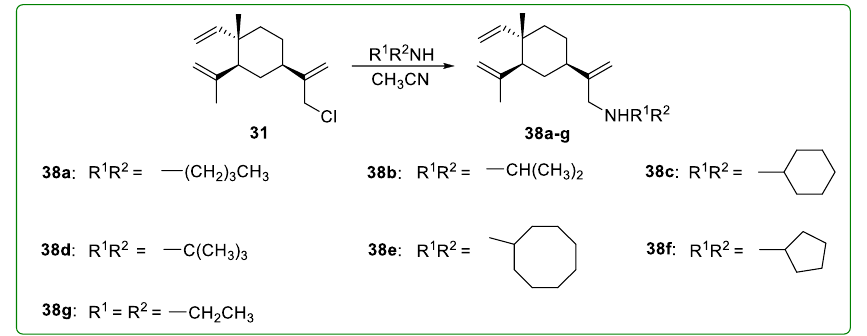
Figure 9. Chemical structures of β -elemene aminated derivatives 38a – g .